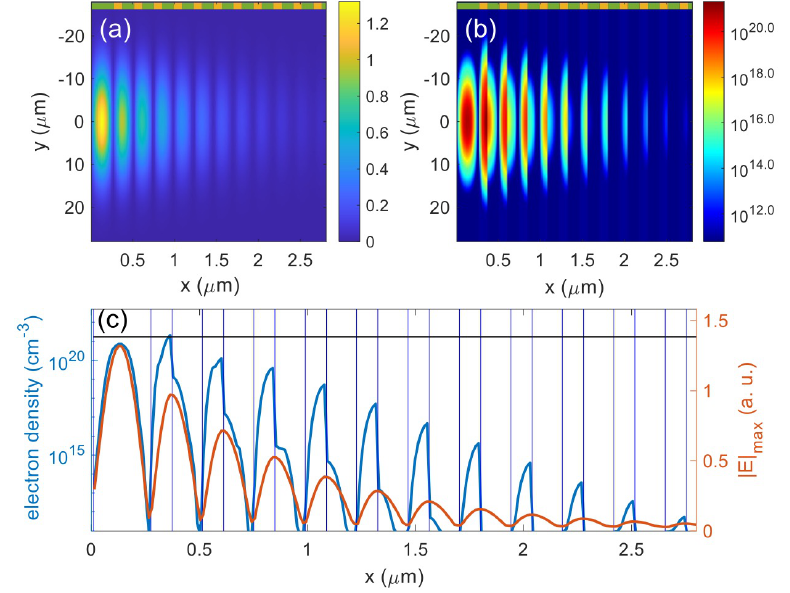
Figure 7. Simulation results for the MLD mirror at 0.7 J/cm 2 . ( a ) | E | max in the mirror; ( b ) Electron density in the mirror; ( c ) Electron density and | E | max profiles at y = 0. The green (SiO 2 ) and yellow (HfO 2 ) blocks indicate different materials. High electron density is only seen in the top layers, so only the top layers are shown here. The peak of the pulse impinges the mirror surface at y = 0 and x = 0 from the left. The black horizontal line denotes the critical